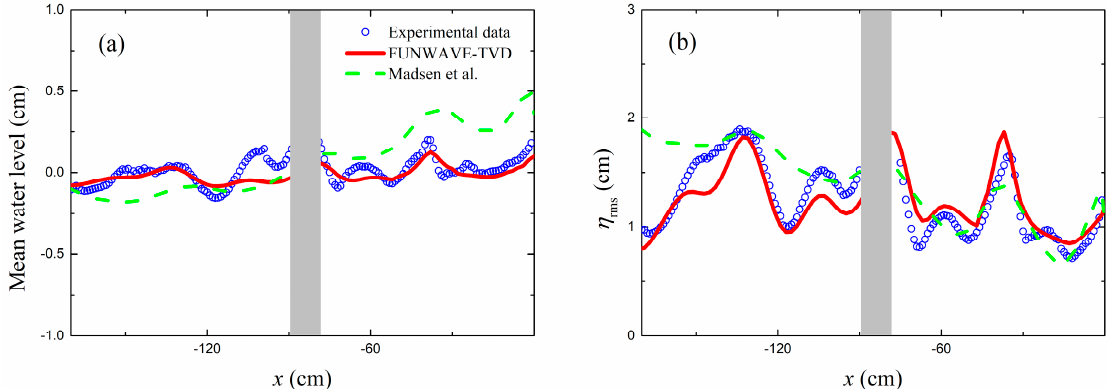
Figure 8. Comparisons of predicted spatial distribution of ( a ) mean water level and ( b ) η rms between Madsen et al. [25] and FUNWAVE-TVD for the wave case with H i = 4.8 cm, T i = 1.2 s, h s = 3 cm.